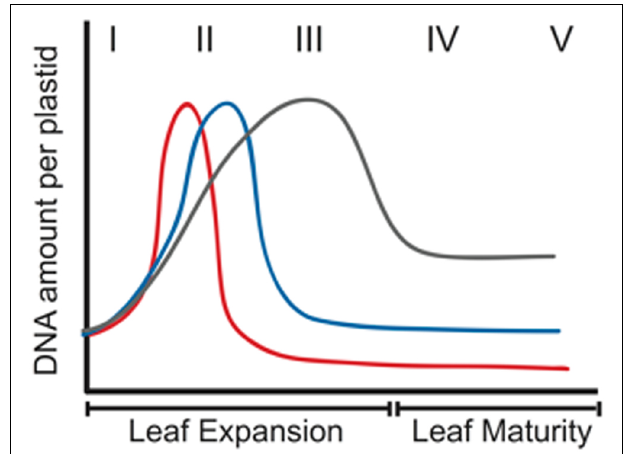
FIGURE 4 | Schematic representation of changes in the amount of ptDNA per plastid during development in three plant species. Increase in ptDNA amount due to ptDNA replication occurs very early in development in maize (red line), followed by a rapid decline. For Arabidopsis (blue line), the increase in ptDNA occurs slightly later and the decline in ptDNA amount is much later. For tobacco (gray line), ptDNA increases more gradually and the decline is less severe. The Roman numerals indicate stages of leaf development. I–III represent expanding leaves, and IV and V represent expanded leaves. (Reprinted from Rowan and Bendich,